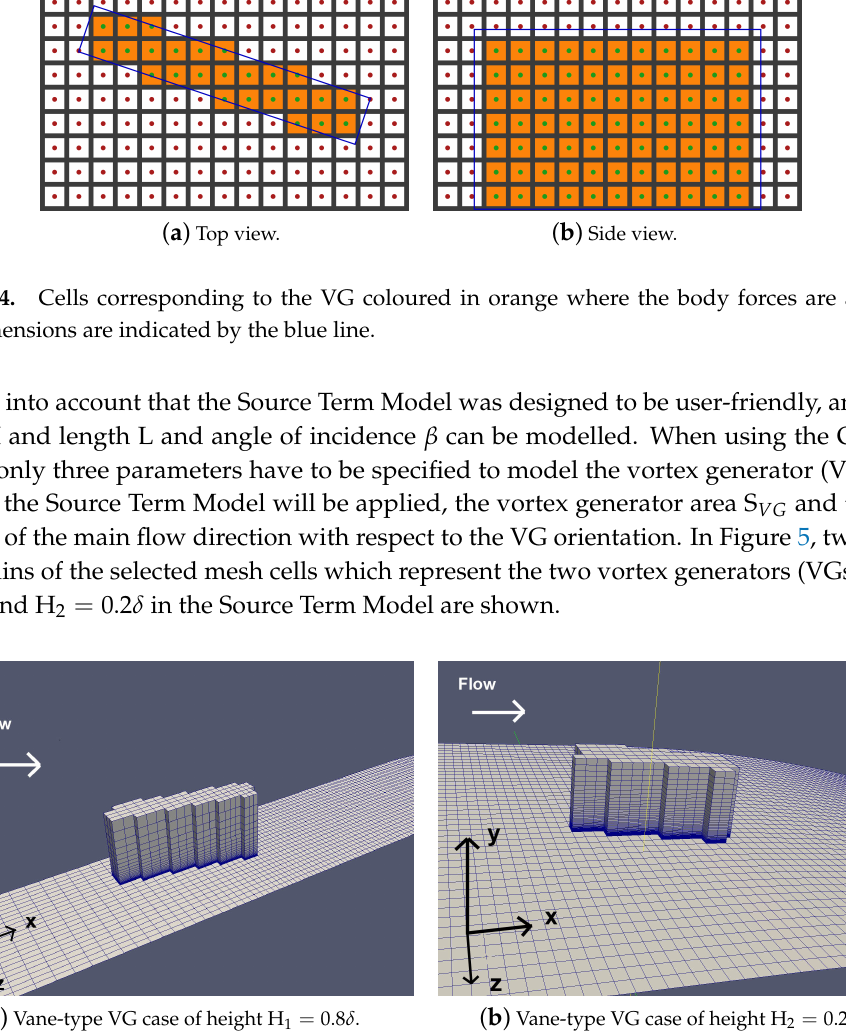
Figure 5. Selected cells representing the two vortex generators (VGs) of heights H 1 and H 2 according to the Source Term Model and positioned on the flat plate upstream the backward-facing